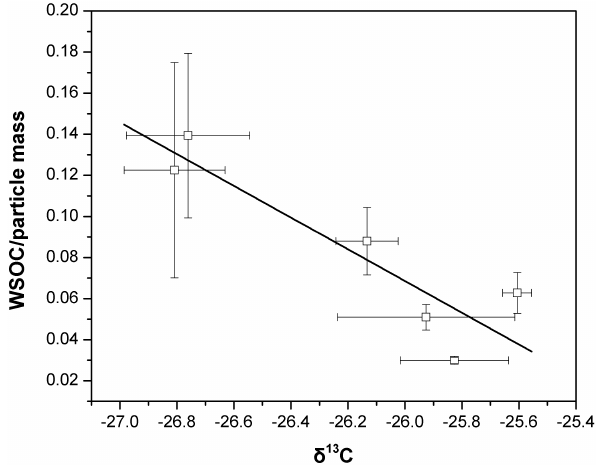
Figure 6. Functional group distributions of WSOC for each im- pactor stage. The boundaries of biomass burning, marine and sec- ondary organic aerosol were obtained from Decesari et al.